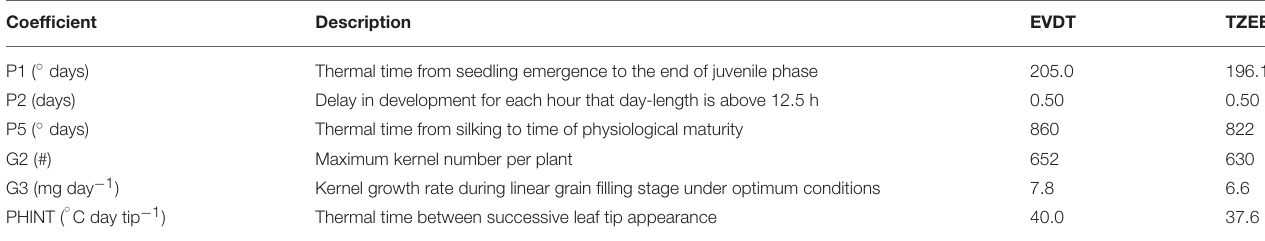
TABLE 2 | Genotype specific parameters for maize varieties used.